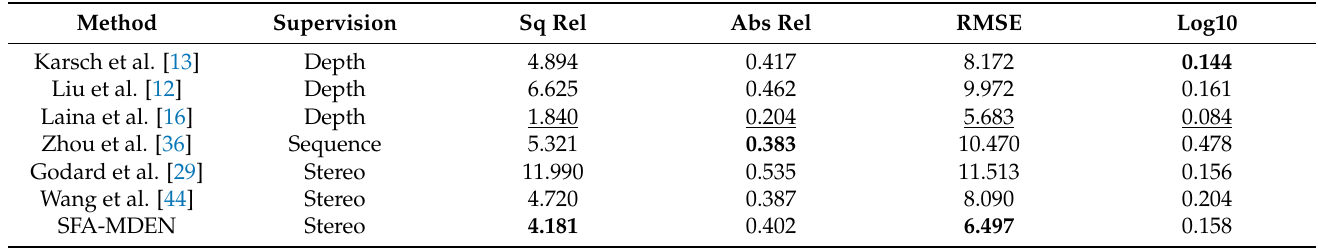
Table 4. Monocular depth estimation evaluation on the Make3D dataset. We highlight the best results with an underline, and bold numbers rank second in each